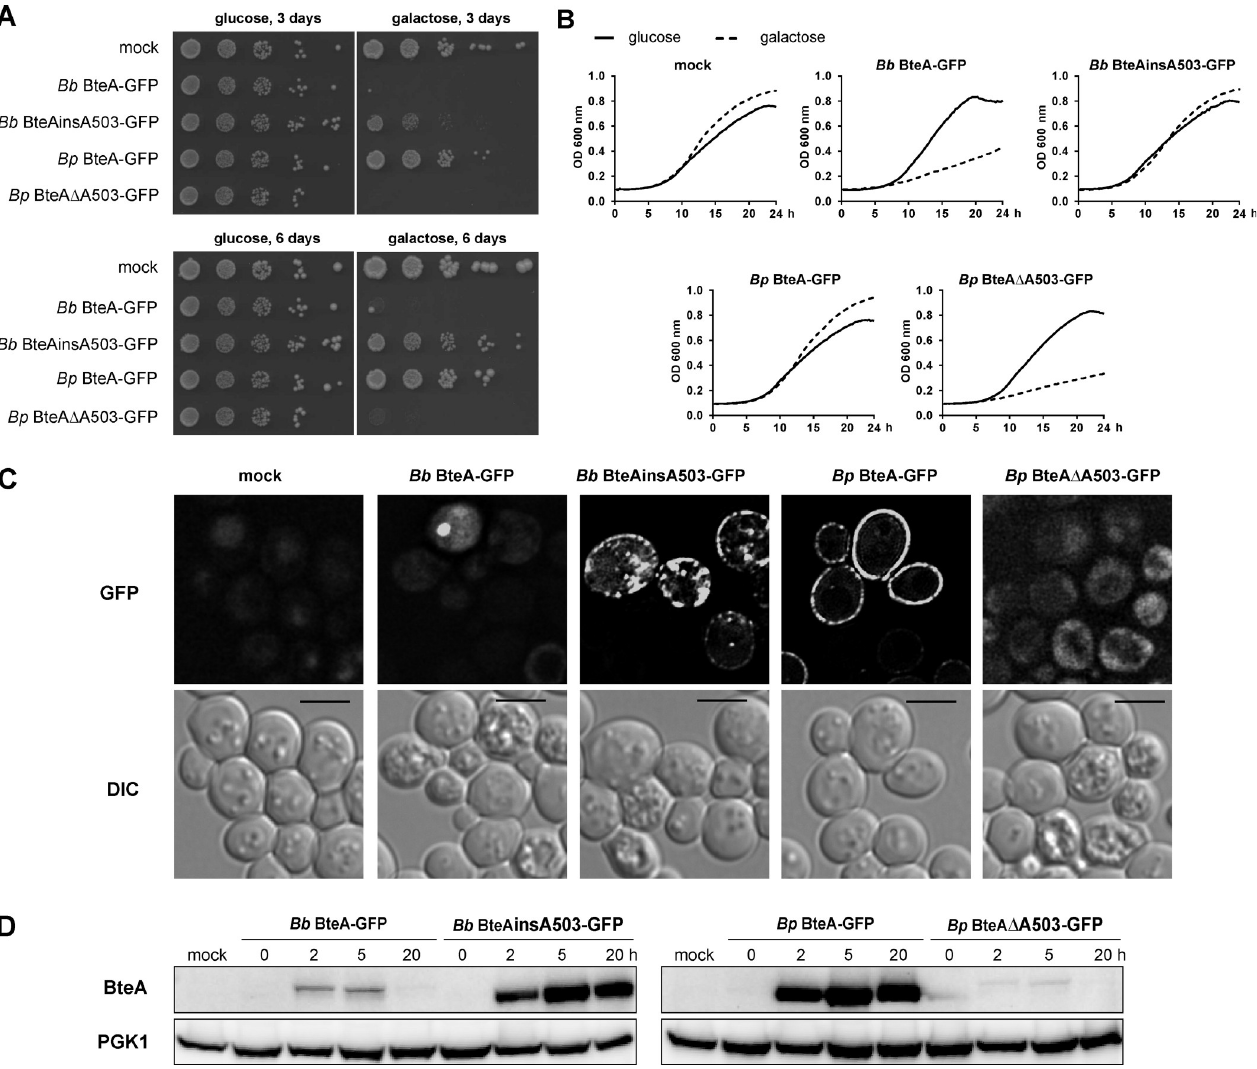
Fig 2. BteA-induced cytotoxicity in yeast is determined by Ala codon at position 503. (A) Spot assay of S . cerevisiae BY4741 strain harboring empty pYC2-CT vector (mock) or the same vector encoding indicated GFP-tagged Bb BteA protein variants of B . bronchiseptica RB50 ( Bb BteA-GFP, Bb RB50 BteAinsA503-GFP), or Bp BteA protein variants of B . pertussis B1917 ( Bp BteA-GFP, Bp BteA Δ A503-GFP). Strains were spotted in ten-fold serial dilutions on the control glucose plates or plates with galactose to induce BteA-GFP expression. Cells were grown at 30˚C for 3 and 6 days. A representative experiment out of 3 is shown. (B) Growth curves of yeast cultures with empty pYC2-CT vector (mock) or the same vector carrying indicated GFP-tagged BteA protein variants in the control glucose medium or in the medium supplemented with galactose. The optical density at 600 nm (OD 600 ) of cultures at 30˚C was recorded every 15 min for 24 h. A representative experiment out of 2 is shown. (C) Live-cell imaging of yeast cells with empty pYC2-CT vector (mock), or the same vector carrying the indicated GFP-tagged BteA proteins variants. Yeast cells were cultivated for 20 h in the medium supplemented with galactose to induce BteA expression. Representative images from 3 independent experiments with the same outcome are presented. Scale bar, 4 μ m (D) Immunoblot analysis of whole- cell lysates of yeast cells expressing indicated GFP-tagged BteA protein variants. Yeast protein extracts were prepared from non-induced culture with empty pYC2-CT vector (mock) and from induced cultures harboring indicated GFP-tagged BteA protein variants encoded on the same vector. Cultures were analyzed 0, 2, 5, and 20 h post-induction with galactose. Equal volumes of extracts (0.4 ml of the culture equivalent; OD 600 = 1) were separated by SDS-PAGE and analyzed by immunoblot using anti-BteA (BteA, 1: 10,000) or anti-PGK1 (PGK1, 1: 5,000) antibodies. PGK1 was used as a loading control. A representative experiment out of 2 is shown.